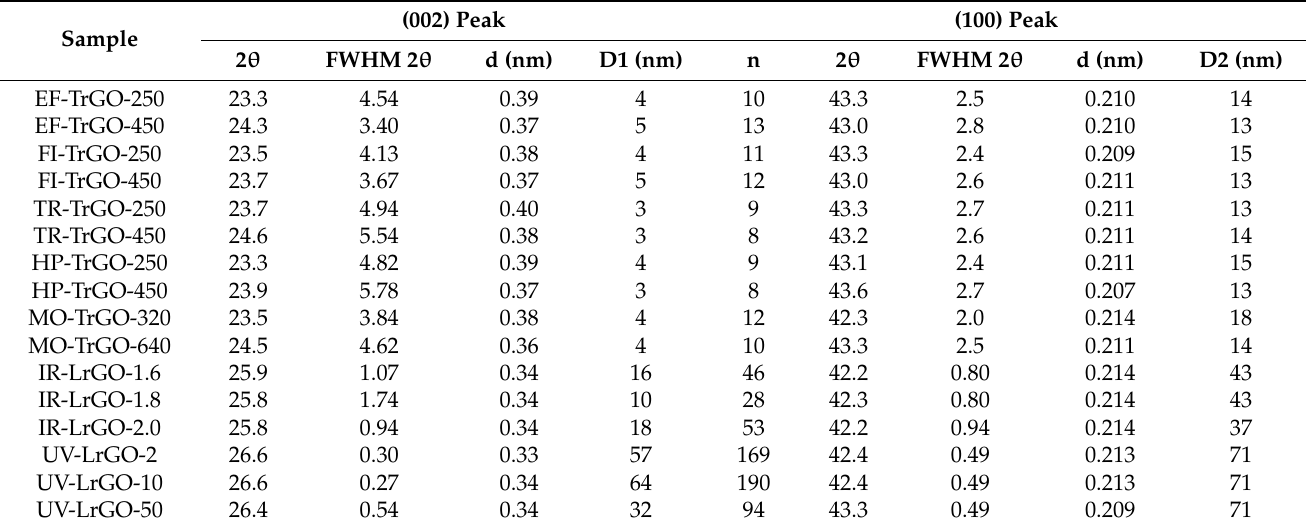
Table 2. Comparison of structural parameters resulting from the XRD analysis of the samples. FWHM: full width at half-maximum, in degrees (deg); d: average distance between rGO layers; D1: average height of each sample stacking nanolayer for peak (002), with constant 0.9; n: average number of rGO layers in the graphene stacking nanolayer; D2: average diameter of each sample stacking nanolayer for peak (100), with constant